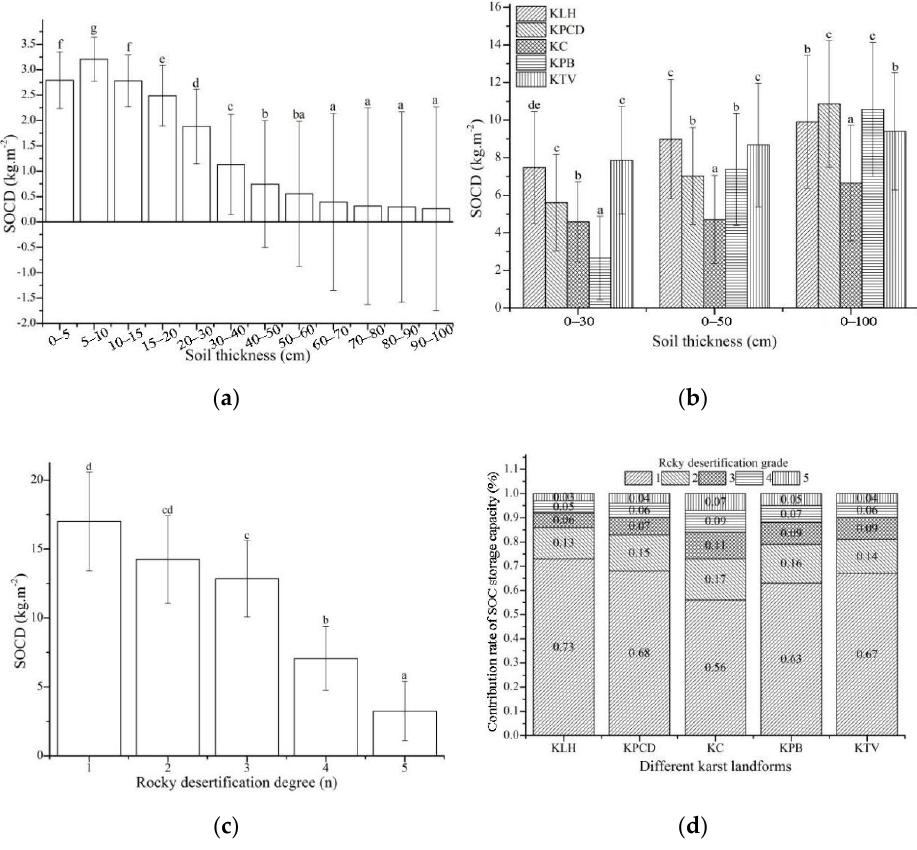
Figure 6. Information on SOC storage capacity spatial distribution. Panel ( a ) shows the vertical distribution of SOCD; ( b ) shows the SOCD in different karst landforms; ( c ) shows the change trend of SOCD with rocky desertification process; ( d ) shows the percentage of SOC storage capacity contribution in different rocky desertification degrees in different karst